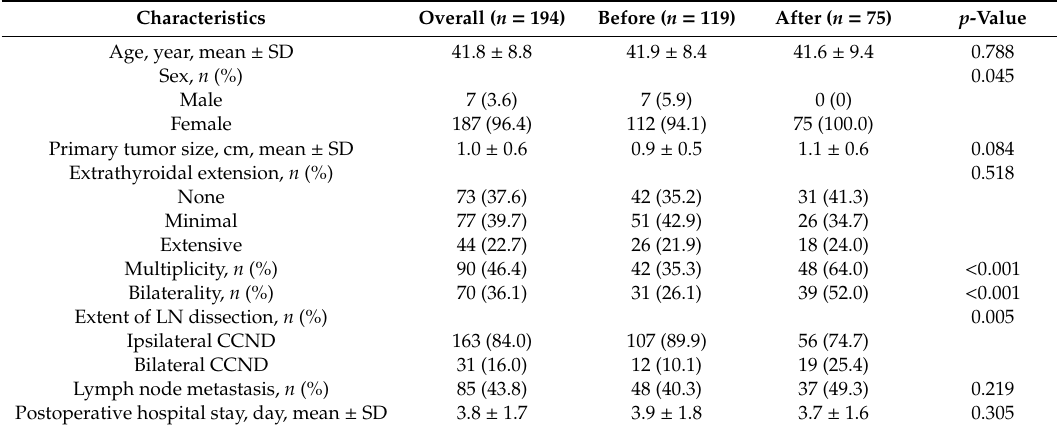
Table 1. Baseline clinicopathologic features of patients who underwent robotic total thyroidectomy with concomitantcentralcompartmentnodedissection, overall, before, andafterthelearningcurveend-point.